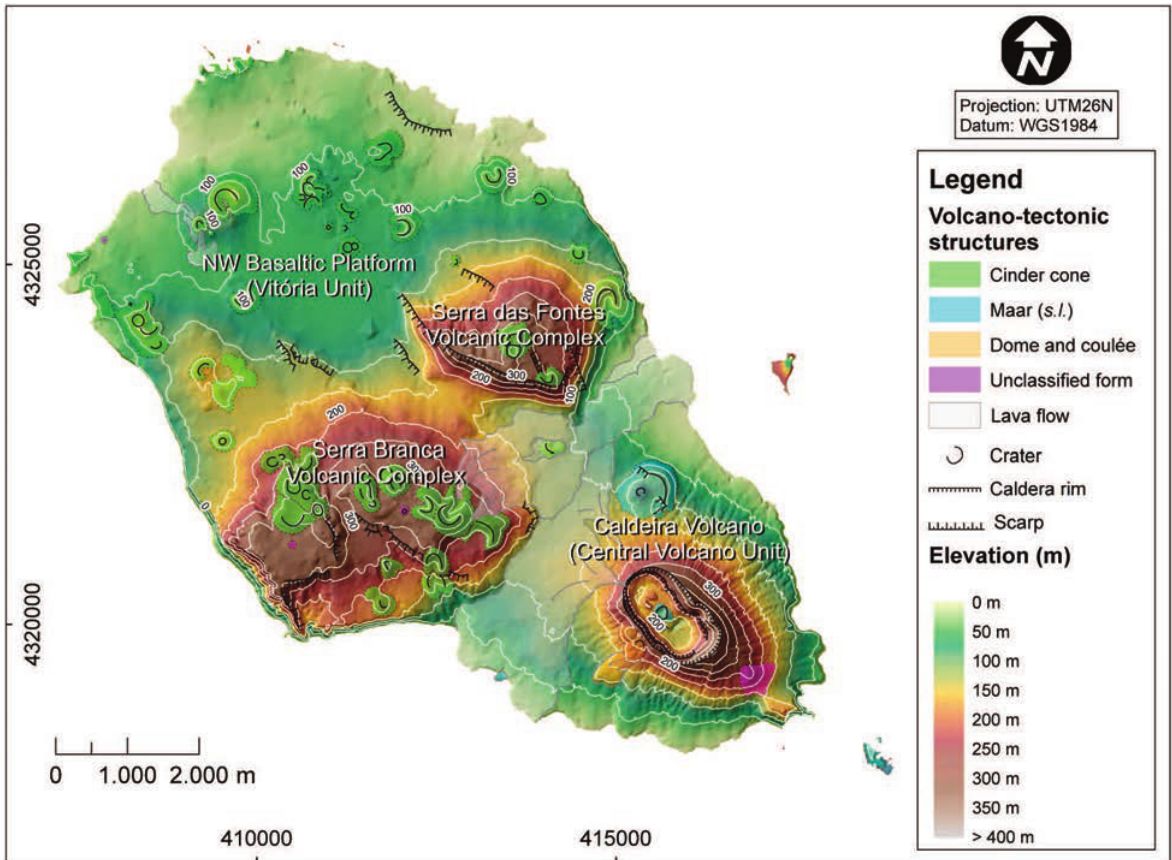
Figure 5. Three-dimensional elevation map of Graciosa Island. Main morphological structures and location of volcanic complexes. Topog- raphy from IGeoE